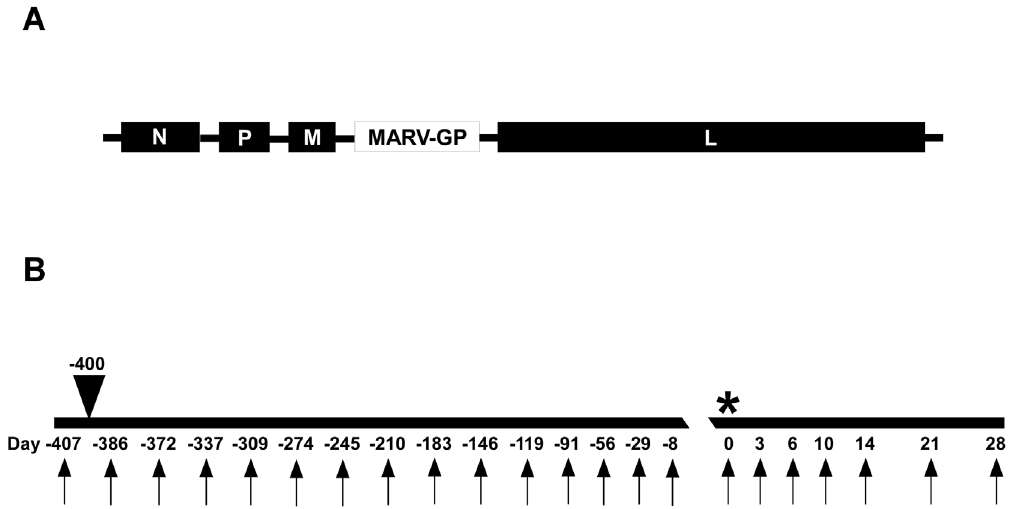
Figure 1. Vaccine and study design. (A) Diagram of the rVSV-MARV-GP genome used in the study design shown in B. (B) Diagram with sample days shown below (arrows), arrow head above depicting day of vaccination (-400), and * depicting the day of challenge (0).